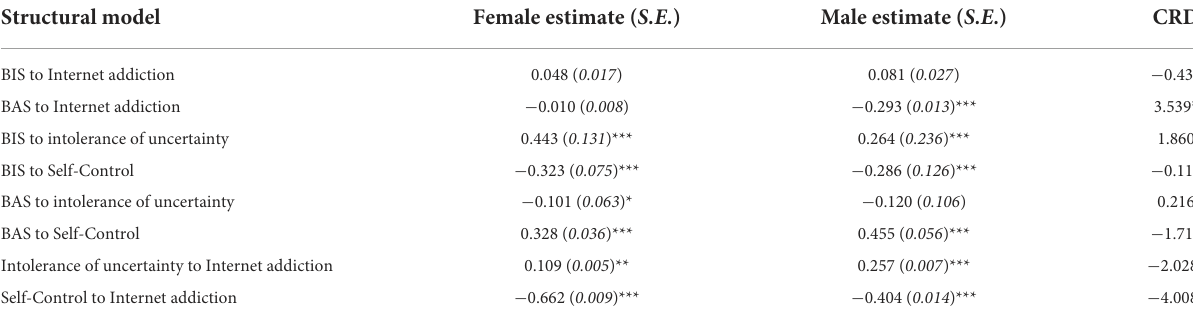
TABLE 4 Standardized coefficients from the multiple–group